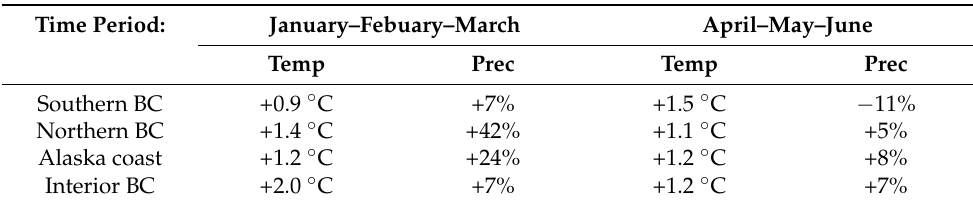
Figure 3. Regional response of vegetation greenness to climate conditions during the year 2021 (dotted lines) compared to historical averages for the 2001–2020 period (solid lines with the ribbon indicating the 25th to 75th quartiles of interannual variation). The 2021 heat wave is indicated with a gray bar. Vegetation greenness is represented by a 16-day enhanced vegetation index (EVI). Temperature time series are based on mean daily records, and precipitation is represented by a 15-day moving average. Regions in columns represent forested landcover as shown in Figure 2. Table 1. Three months average temperature and precipitation anomalies, representing longer-term climatic conditions leading up to the heat wave